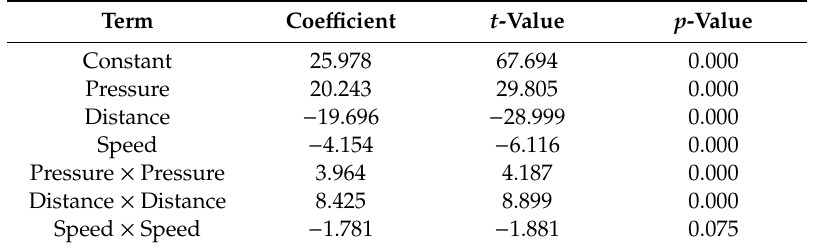
Table 4. The estimated regression coe ffi cients for the sandblasting model using #600 abrasive. Term Coe ffi cient t -Value p